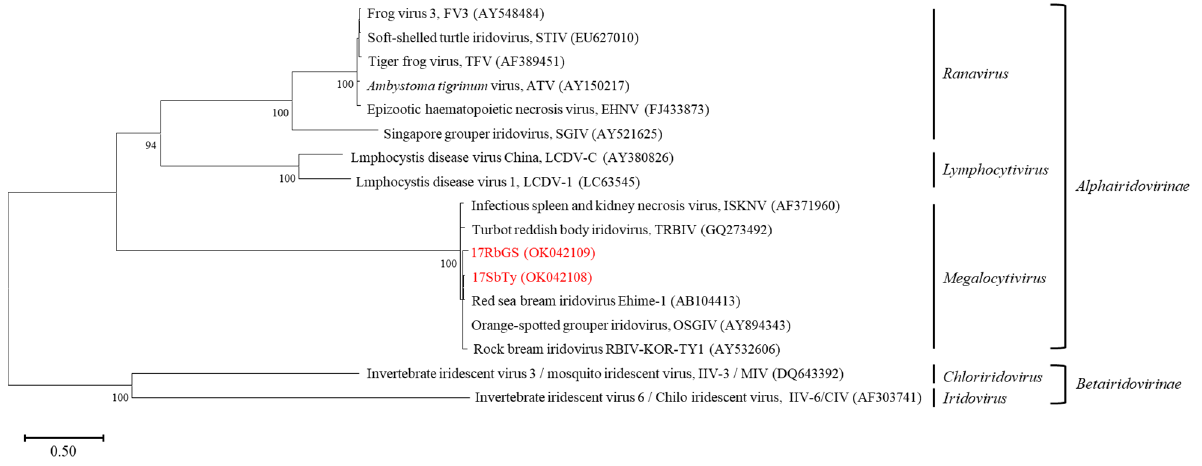
Figure 3. Phylogenetic trees based on the deduced amino acid sequences of the 26 concatenated genes conserved for members of the family Iridoviridae . The tree was constructed by the maximum-likelihood method under the LG model and gamma-distributed rates with invariant sites (LG + G4 + I) in MEGA (ver. 11). The two RSIV isolates (17SbTy and 17RbGs) from this study are highlighted in bold and red color.